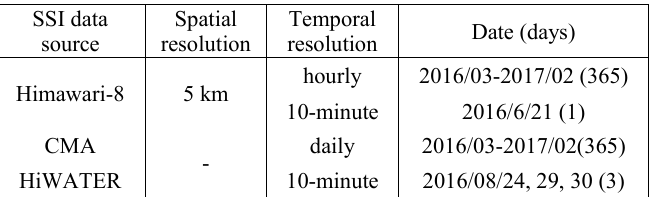
Table 1. Details of the data products used in this research.